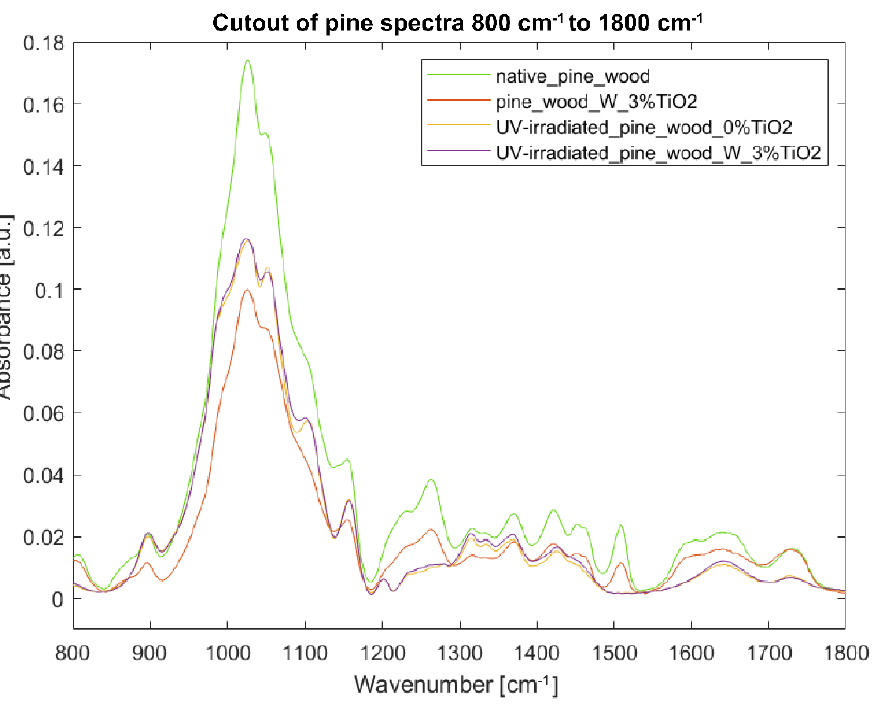
Figure 9. FTIR-ATR spectra of pine wood samples: (green) reference sample of native pine wood, (red) pine wood with 3% TiO 2 coating with water as binder, (yellow) UV-irradiated pine wood without TiO 2 coating, and (purple) UV-irradiated pine wood with 3% TiO 2 coating with water as binder.